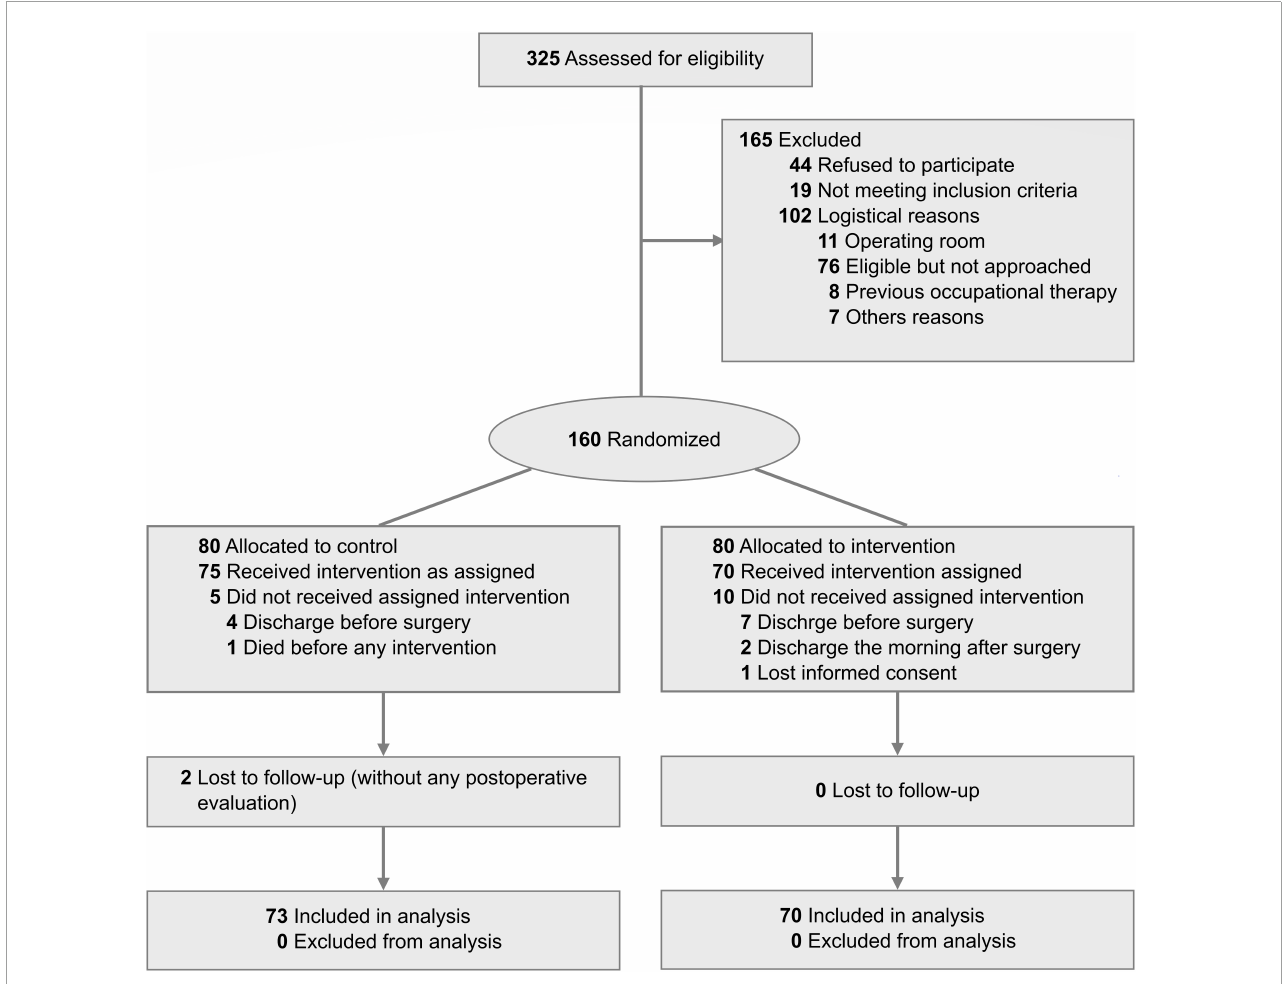
FIGURE1 CONSORT diagram. Of the 325 patients eligible for screening, 160 patients provided consent and were randomized, 80 standard non-pharmacological delirium prevention of control group and 80 to occupational therapy intervention. Overall, 73 patients were analyzed for the control group and 70 for the intervention group, which concluded their interventions and